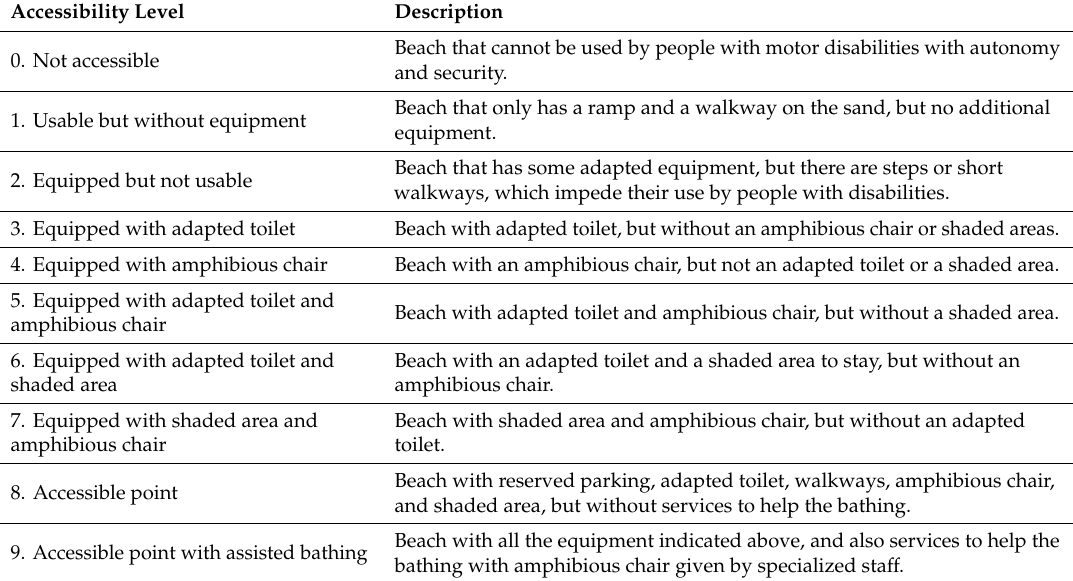
Table 2. Definition of the levels of accessibility to the